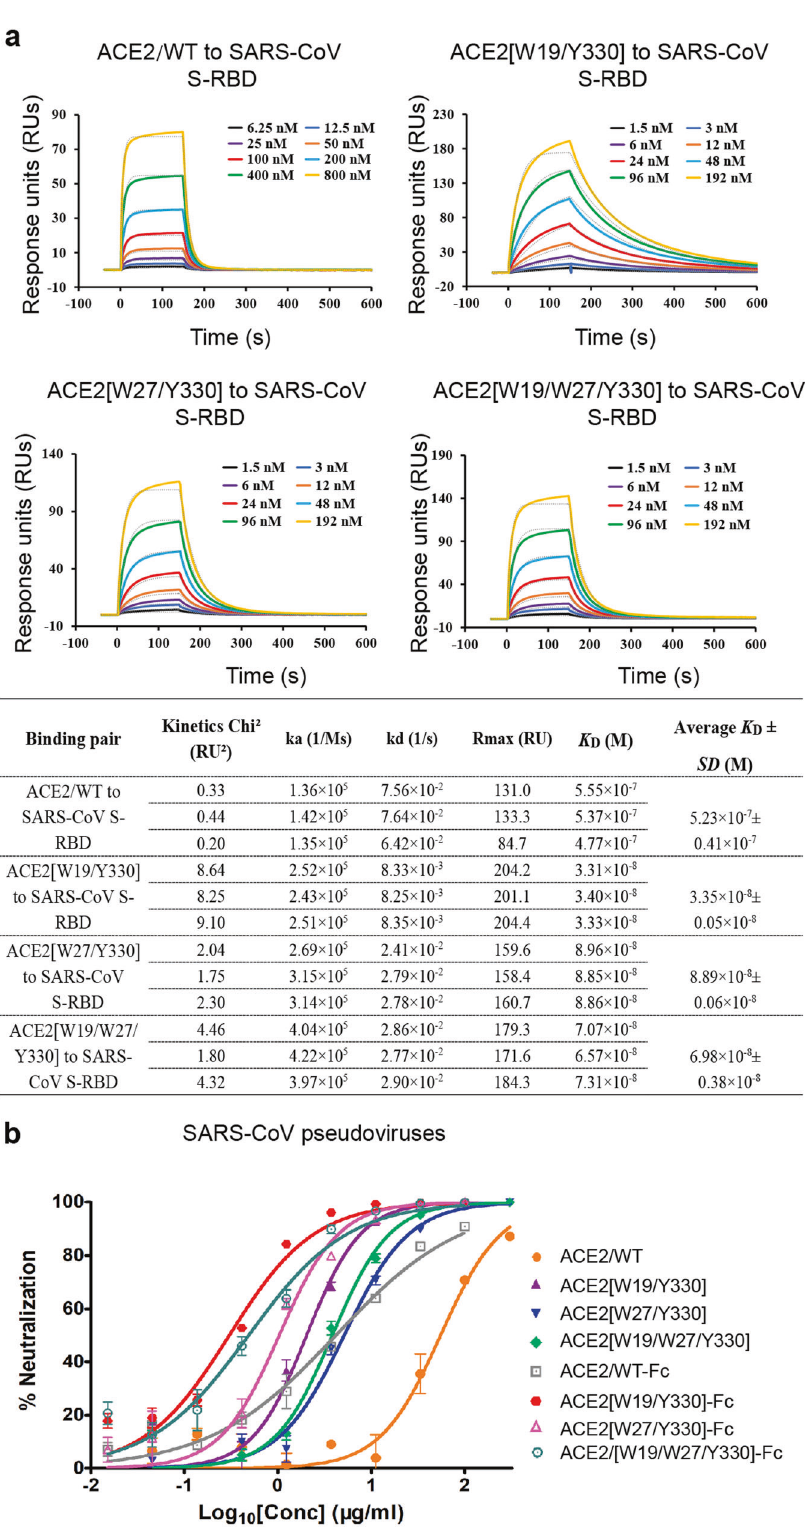
Signal Transduction and Targeted Therapy (2021)